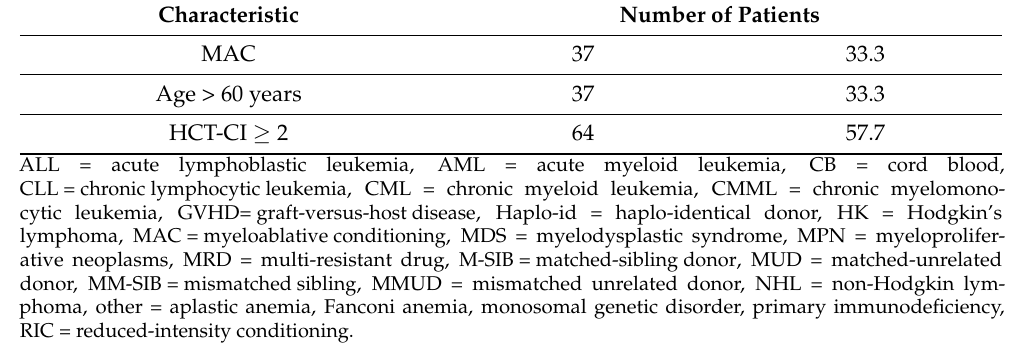
Table 1. Cont. Characteristic Number of